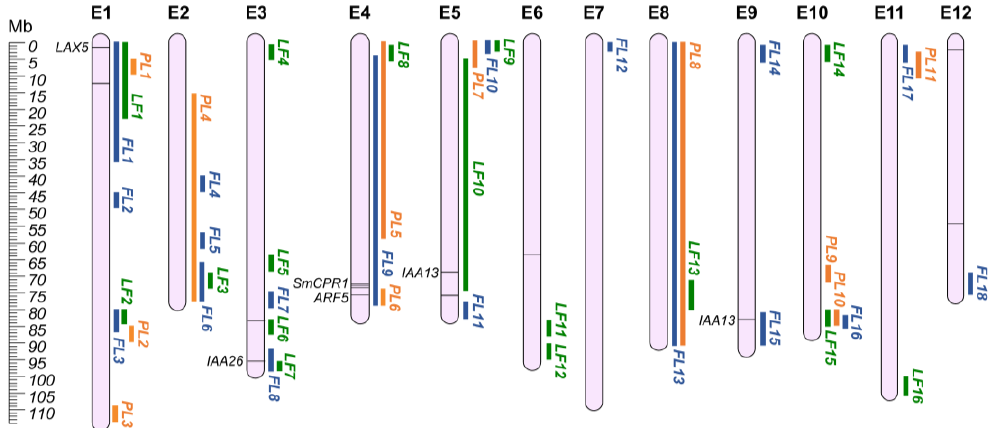
Figure 1. Morphological QGRs chromosome map (E1 – E12). Orange: Plant QGRs (PL); Green: Leaf QGRs (LF); Blue: Flower QGRs (FL). Main candidate genes are reported in italics, while information about the other candidates (represented by bars on the chromosomes) are shown in Table S3.